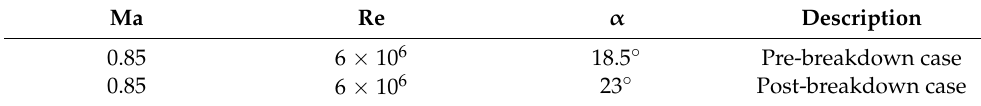
Figure 4. Delta wing model. Table 3. Computing states of delta